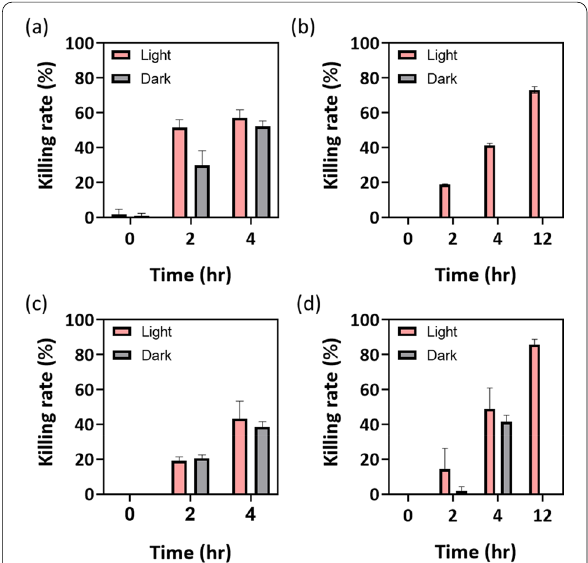
Fig. 3 Cell viability with purified 5‑ALA treatment among different incubated time. Killing rate of ( a) 0.5% and ( b) 1% 5‑ALA treatment to A549 human lung cancer cells. Killing rate of ( c) 0.5% and ( d) 1% 5‑ALA treatment to A375 melanoma skin cancer cells